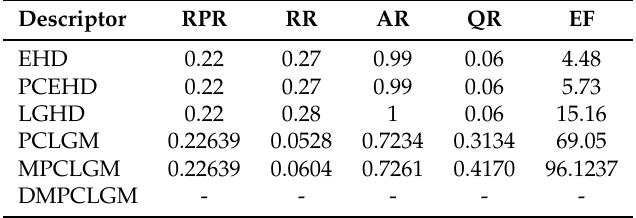
Table 4. Comparison of the six algorithms using the Potsdam data